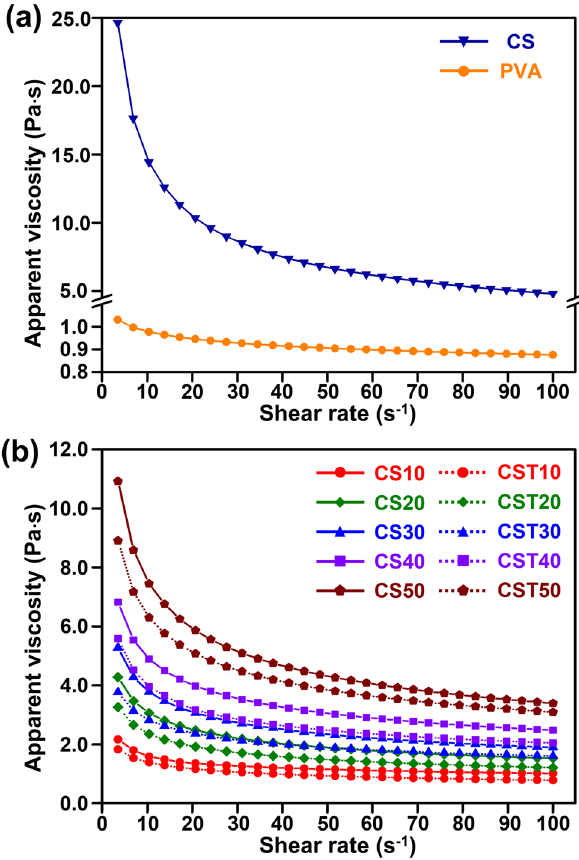
Figure 1: Relationship between apparent viscosity and shear rate of: ( a ) CS and PVA solutions and ( b ) spinning solutions in various conditions with and without T80